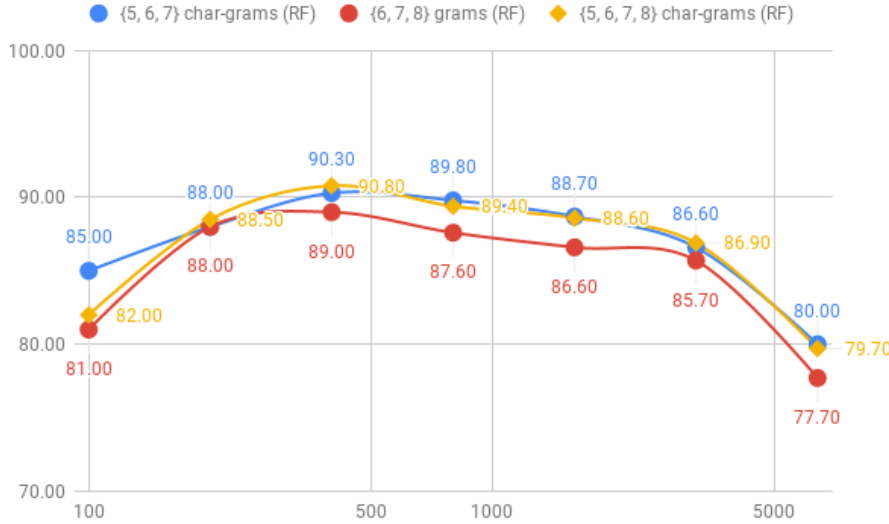
Figure 12. Comparison of the accuracy between {5, 6, 7}, {6, 7, 8} and {5, 6, 7, 8} char-grams for the RF classifier.